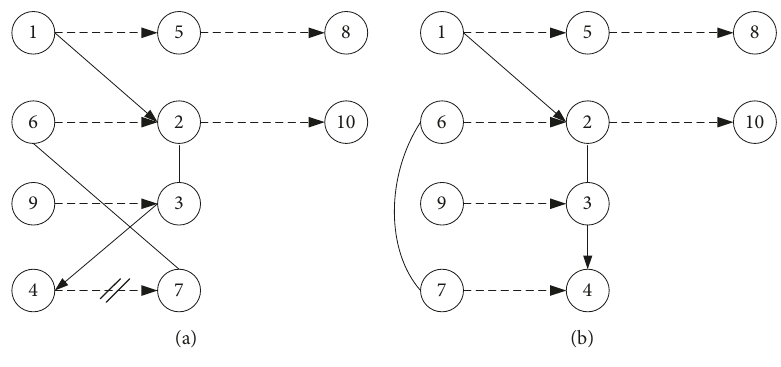
Figure 15: Chromosome repair.